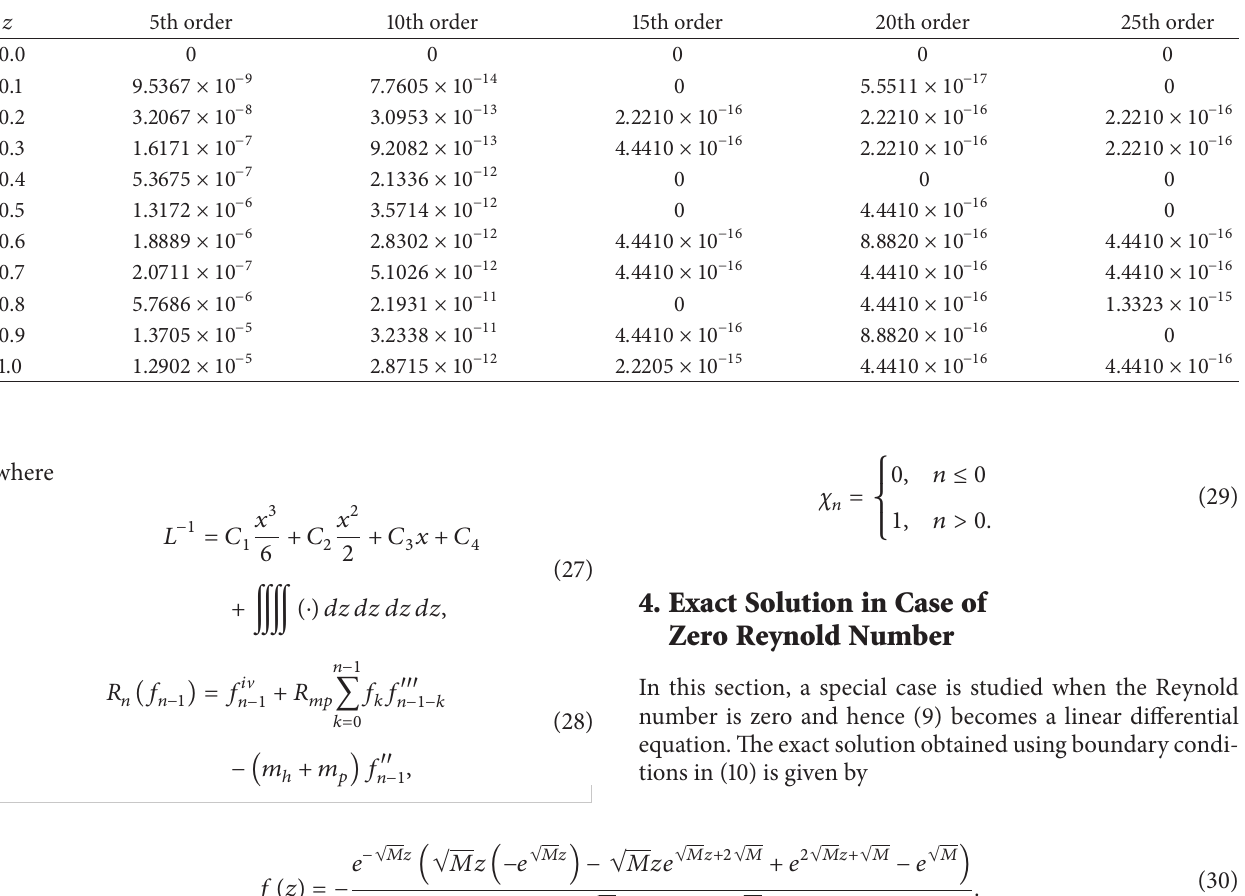
Table 1: Absolute residuals keeping 𝑚 ℎ = 𝑚 𝑝 = 0.5 and 𝑅 𝑚𝑝 = 1 . Absolute residuals for different order HAM solutions